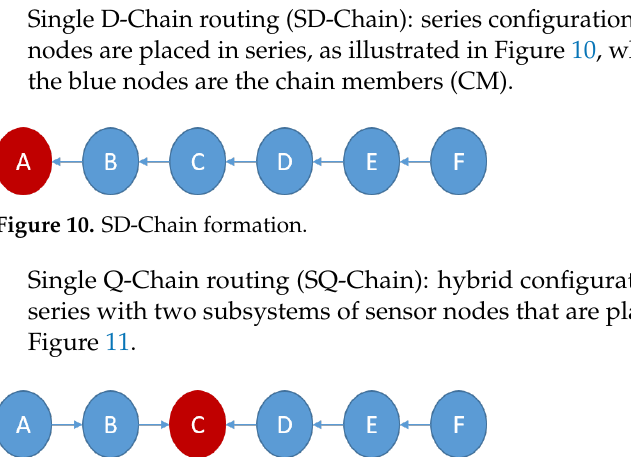
Figure 11. SQ-Chain